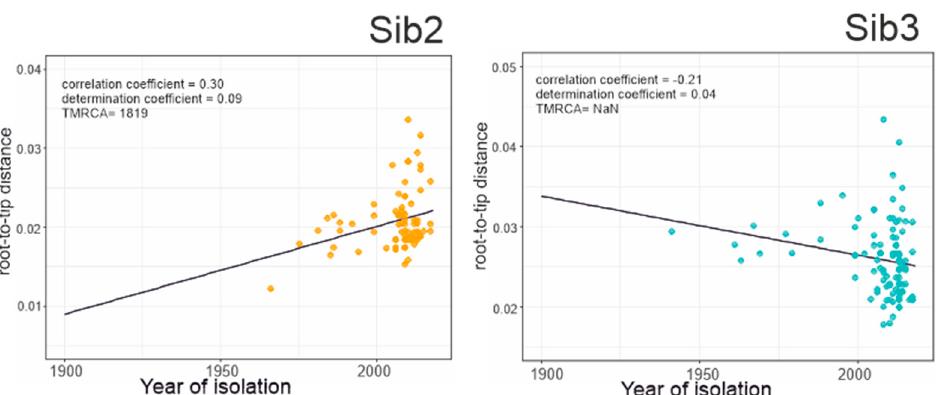
Figure 4. Association between root-to-tip distance and time of isolation for separated TBEV groups.